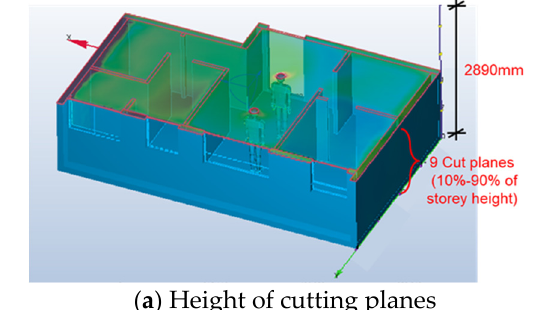
Figure 8. Cutting planes and data points.